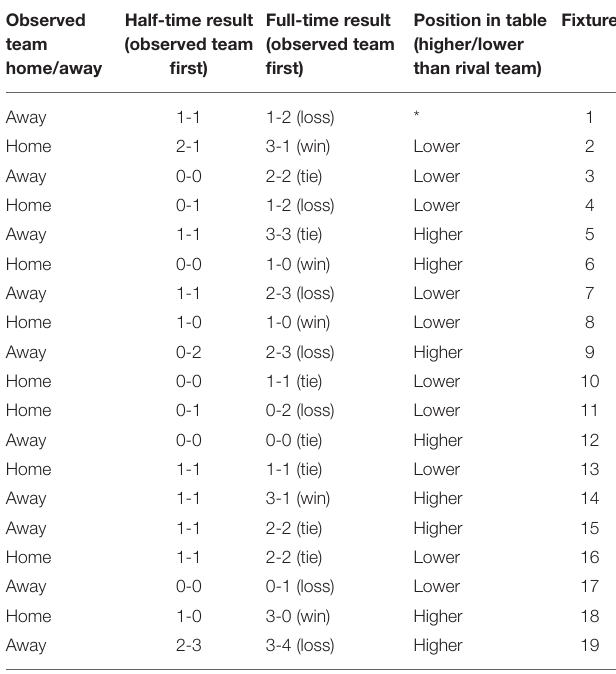
TABLE 1 | Half-time and full-time results for the observed